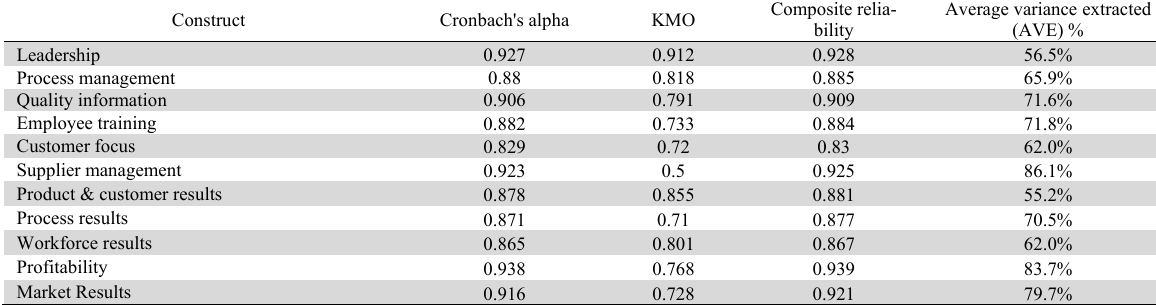
Unidimensionality, Convergent Validity and Reliability Construct Cronbach's alpha KMO